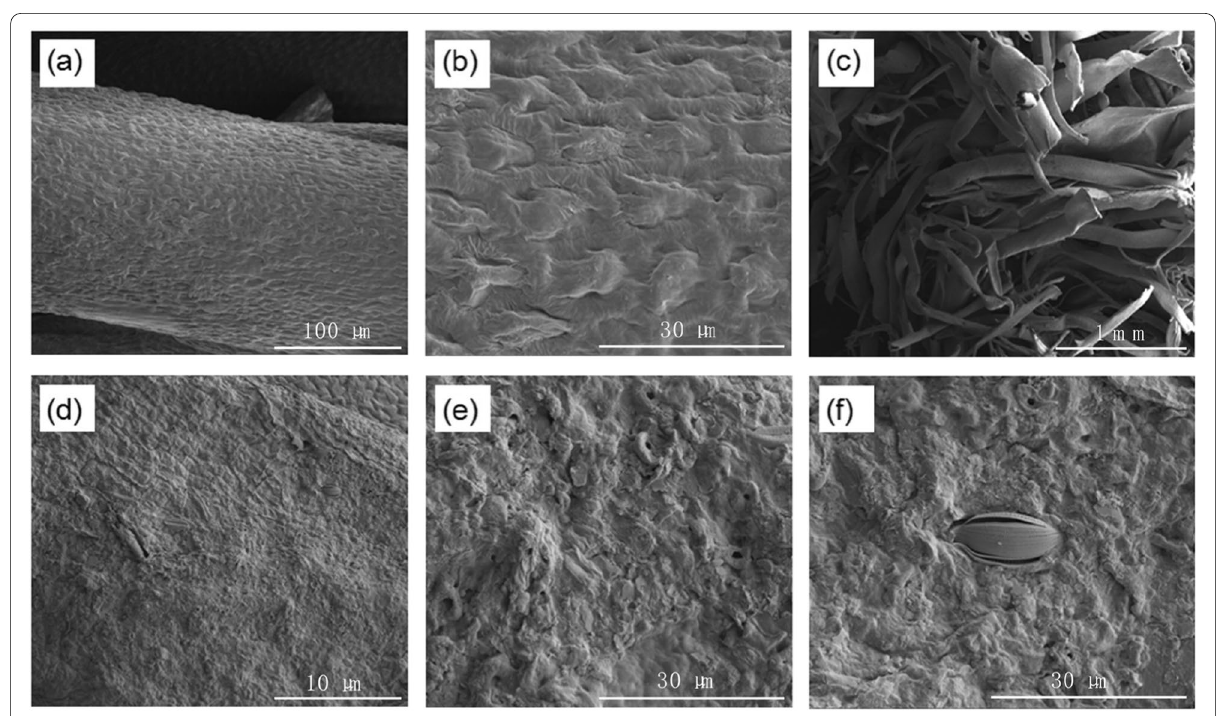
Fig. 4 SEM photographs of E. prolifera in biogas